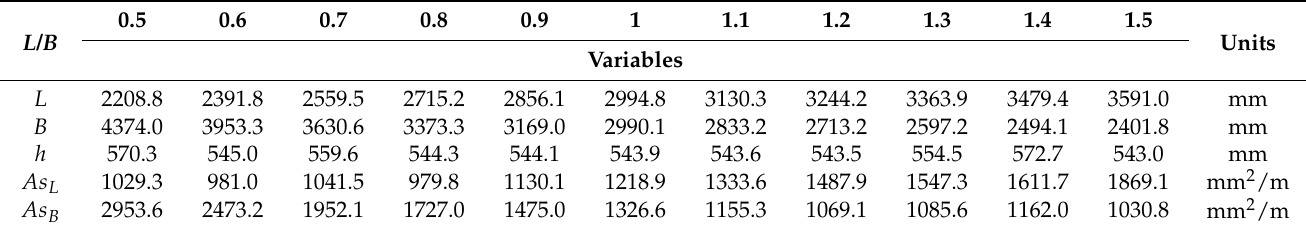
Table 8. Variables obtained for example 1 by varying aspect ratio.